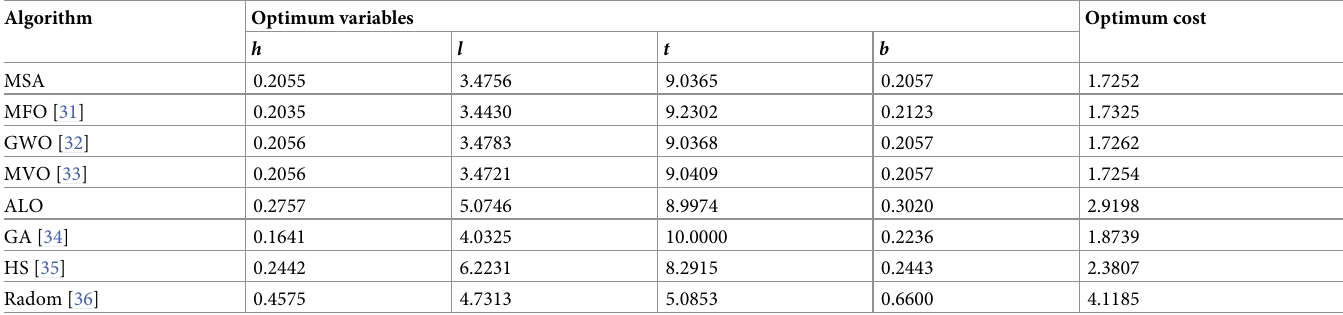
Table 8. Comparison results of the welded beam.